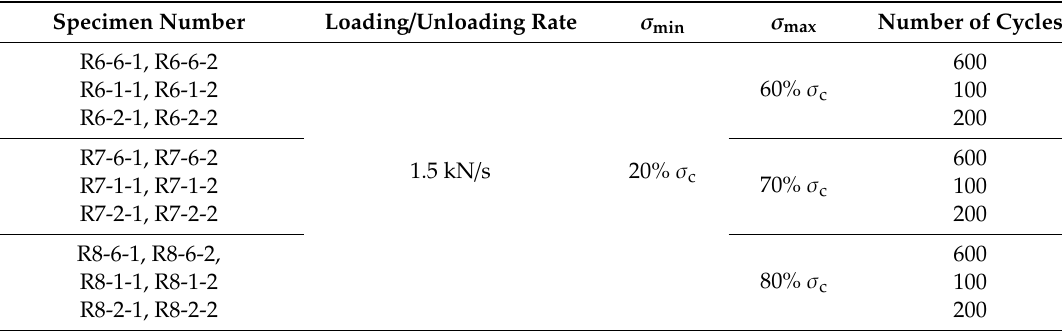
Figure 4. Stress path diagram of uniaxial loading and unloading test. Table 1. Cyclic loading test scheme.